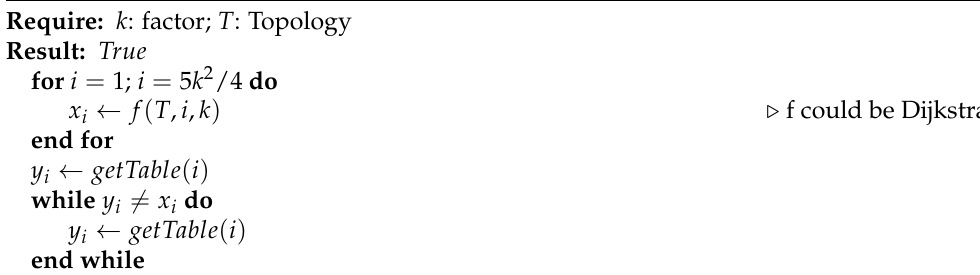
Algorithm 1 Convergence with pre-computed tables (centralized approach).